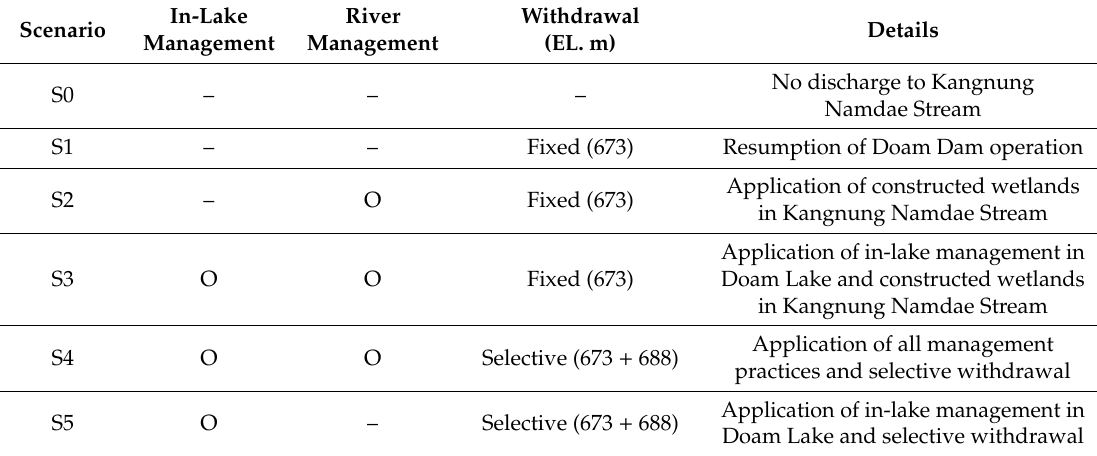
Table 3. Experimental